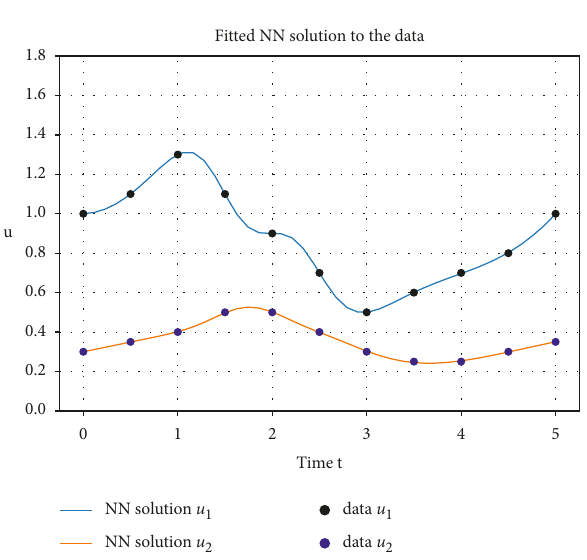
Figure 4: Neural network solution and the measured data for Example